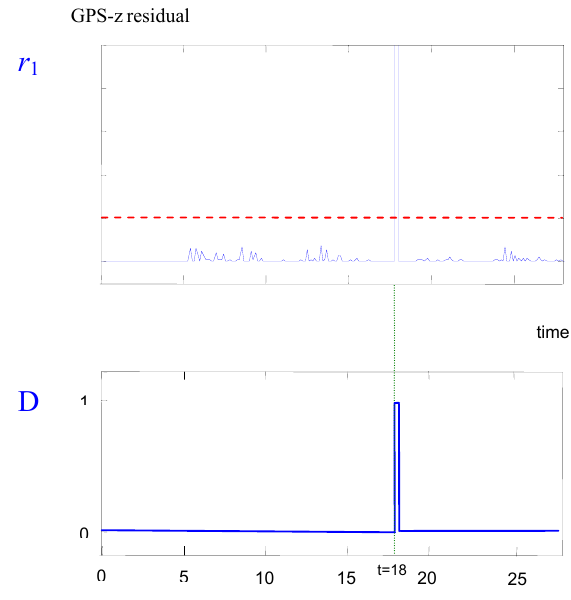
Figure 2. Outlier GPS-z sensor failure detection. Upper plot: residual signal. Lower plot: fault detection